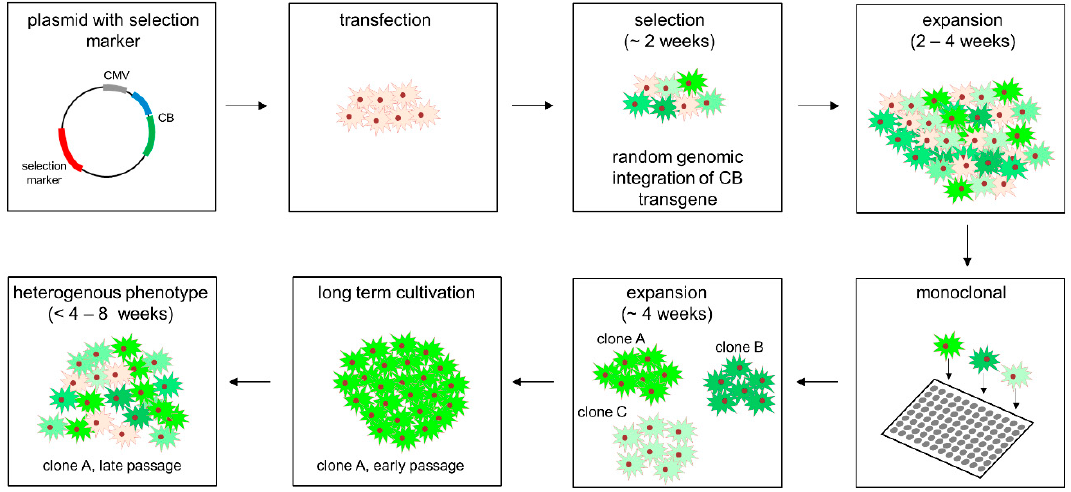
Figure 1. Typical workflow of stable chromobody cell line generation following random genomic integration of chromobody (CB) transgene.